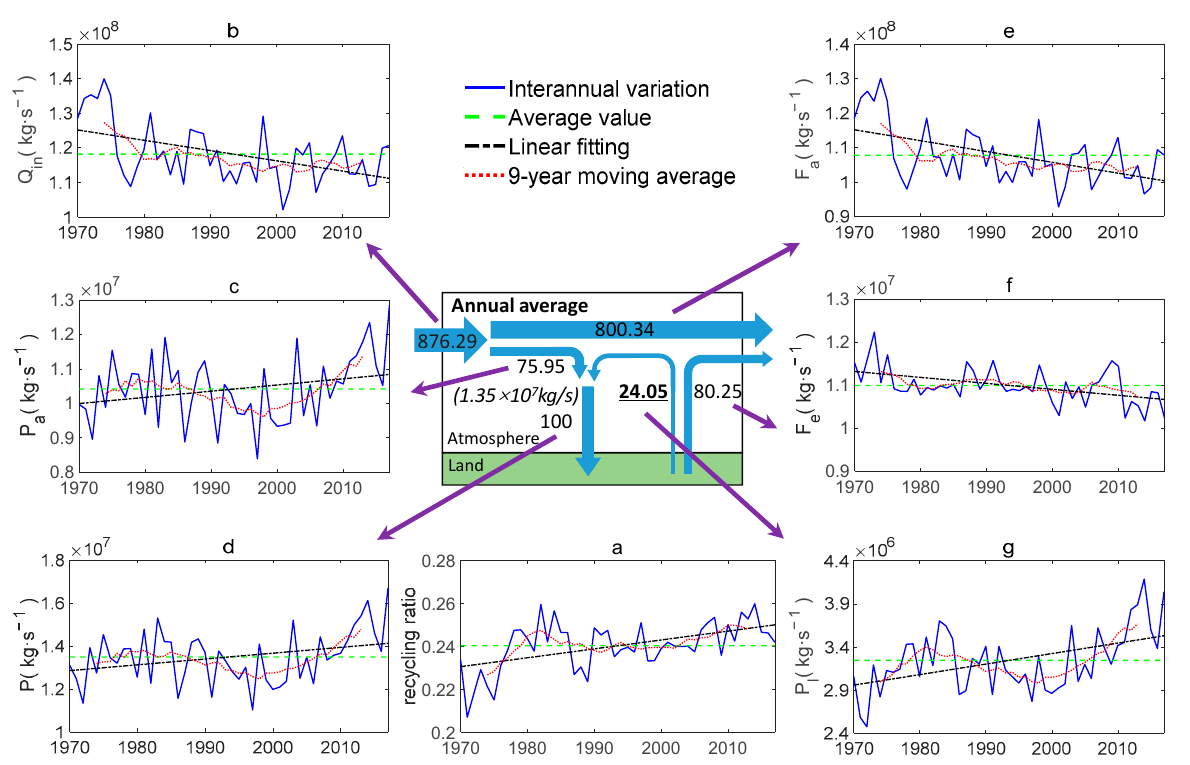
Figure 3. Characteristics of the atmospheric moisture cycle in SAIE from 1970 to 2017. The middle figure schematically illustrates the mean annual water cycle over the region. Panel ( a ) shows the interannual variation of the PRR (precipitation recycling ratio) over SAIE, and ( b – g ) show the interannual changes of the water cycle components in the region, including the ( b ) Q in (the total water vapor input into the region in the horizontal direction, ( c ) P a (the component of precipitation arising from advected moisture), ( d ) P (the precipitation in the region), ( e ) F a (the part of horizontal flux flowing out of the region), ( f ) F e (the part of the locally evaporated moisture that translates out of the region), and ( g ) P l (the part of the regional precipitation contributed by local evaporation). All variables have been standardized by dividing by the annual mean area-integrated precipitation and then multiplying by 100.